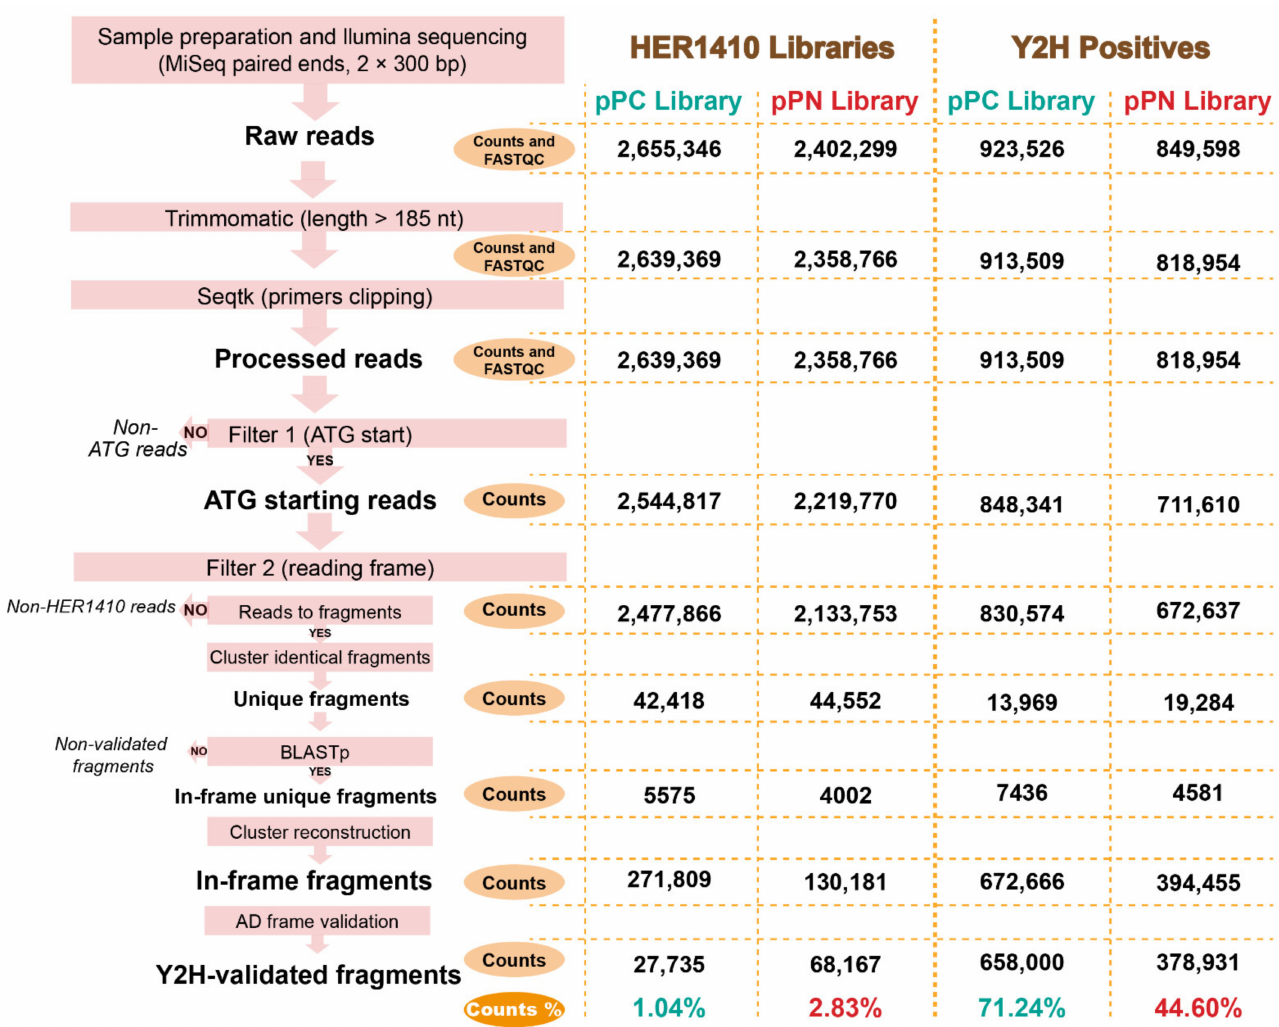
Figure 2. Analysis of the high-throughput sequencing data from the B. thuringiensis HER1410 genomic libraries and Y2H positive hits. Bioinformatics pipeline for the Y2H-HTS data analysis. Schematic representation of the different steps that were followed for sequencing the data processing of Y2H libraries and Y2H positives. After each step, the number of reads or fragments was calculated (counts). For each library, these counts are indicated in the two columns on the right (pPC: teal, pPN: red). For the Y2H positives, only the reads over 300 bp are detailed, see Supplementary Figure S9 for the complete analysis. The final percentage of validated reads is indicated. In the first few steps, FastQC was used to evaluate the quality of the reads, as illustrated in Supplementary Figure